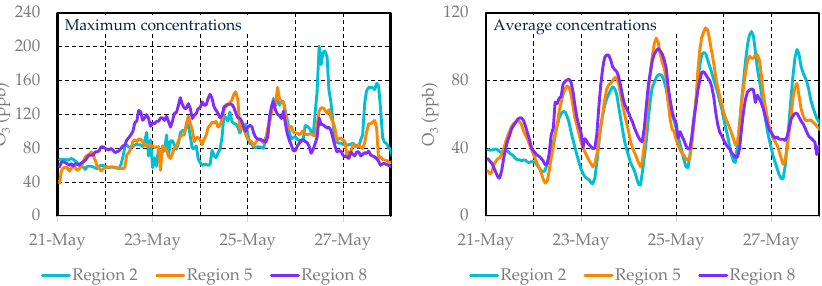
Figure 10. Time series of ozone concentrations in regions 2, 5 and 8 (left: maximum ozone concen- tration in the regions, right: average ozone concentration in the regions).